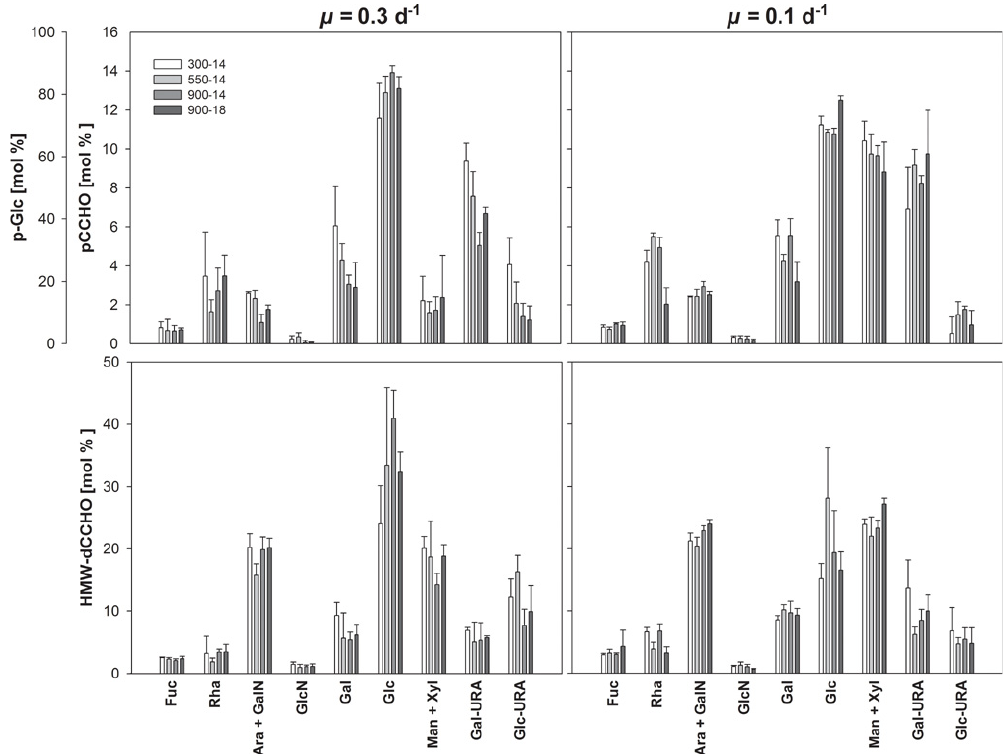
Fig. 3. Composition of particulate combined carbohydrates (pCCHO, upper panels) and high molecular weight ( > 1kDa) dissolved CCHO (HMW-dCCHO) (lower panels) at various growth, CO 2 and temperature conditions. Mean values and standard deviations are given as mol % and were derived from sampling 1, 2 and 3 ( µ = 0 . 3d − 1 ) and sampling 4, 5 and 6 ( µ = 0 . 1d − 1 ) ,